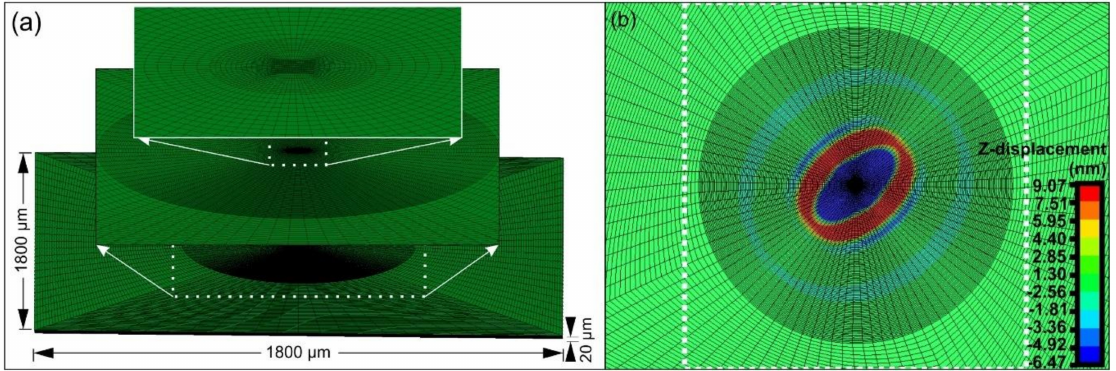
Figure 2. The FEM model. ( a ) Geometry and mesh. ( b ) Representative result of simulated ultrasound propagation 60 ns after the beginning of laser